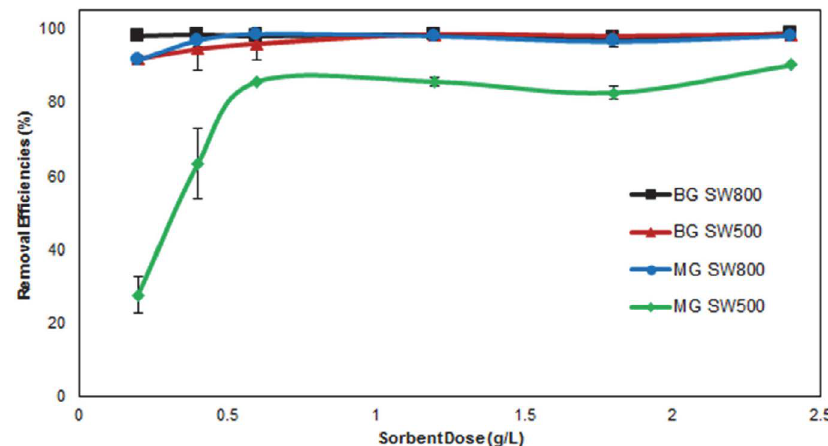
Figure 5. Effect of adsorbent dose on the removal of BG and MG (adsorbent dose range 0.2–2.4 g/L, initial dye concentration 20 mg/L, volume 25 ml, contact time 24 h, n =